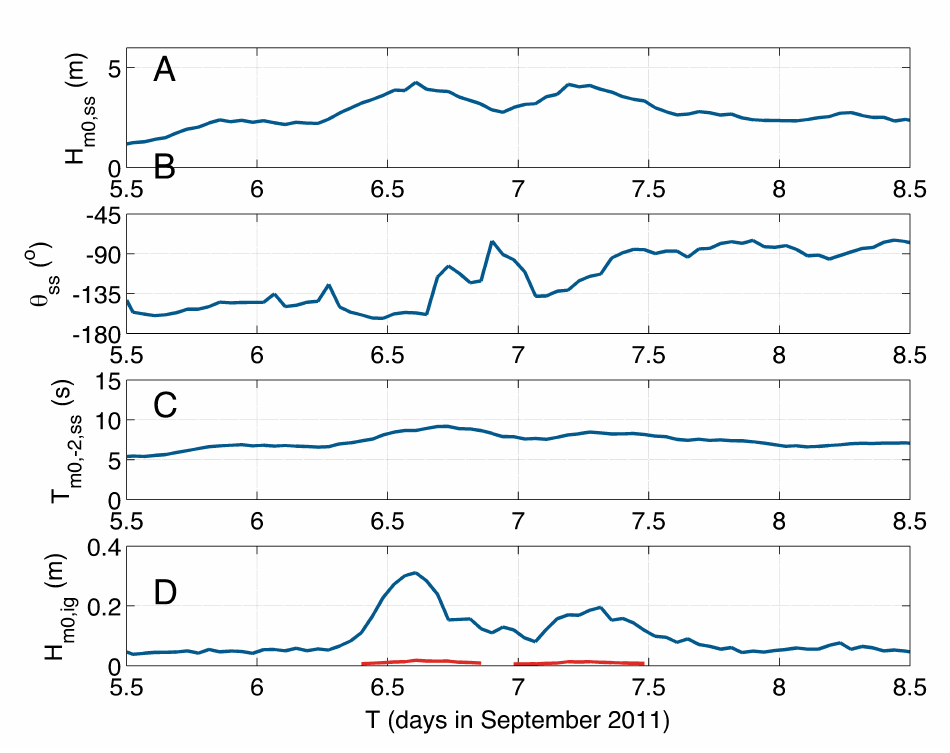
Figure 10. Sea-swell and IG conditions at A12 in September 2011. ( A ) Significant wave height H m 0, ss . ( B ) Wave period T m 0, − 2 . ( C ) Mean wave direction θ ss (Nautical convention). ( D ) Bound (red) and total (blue) IG wave